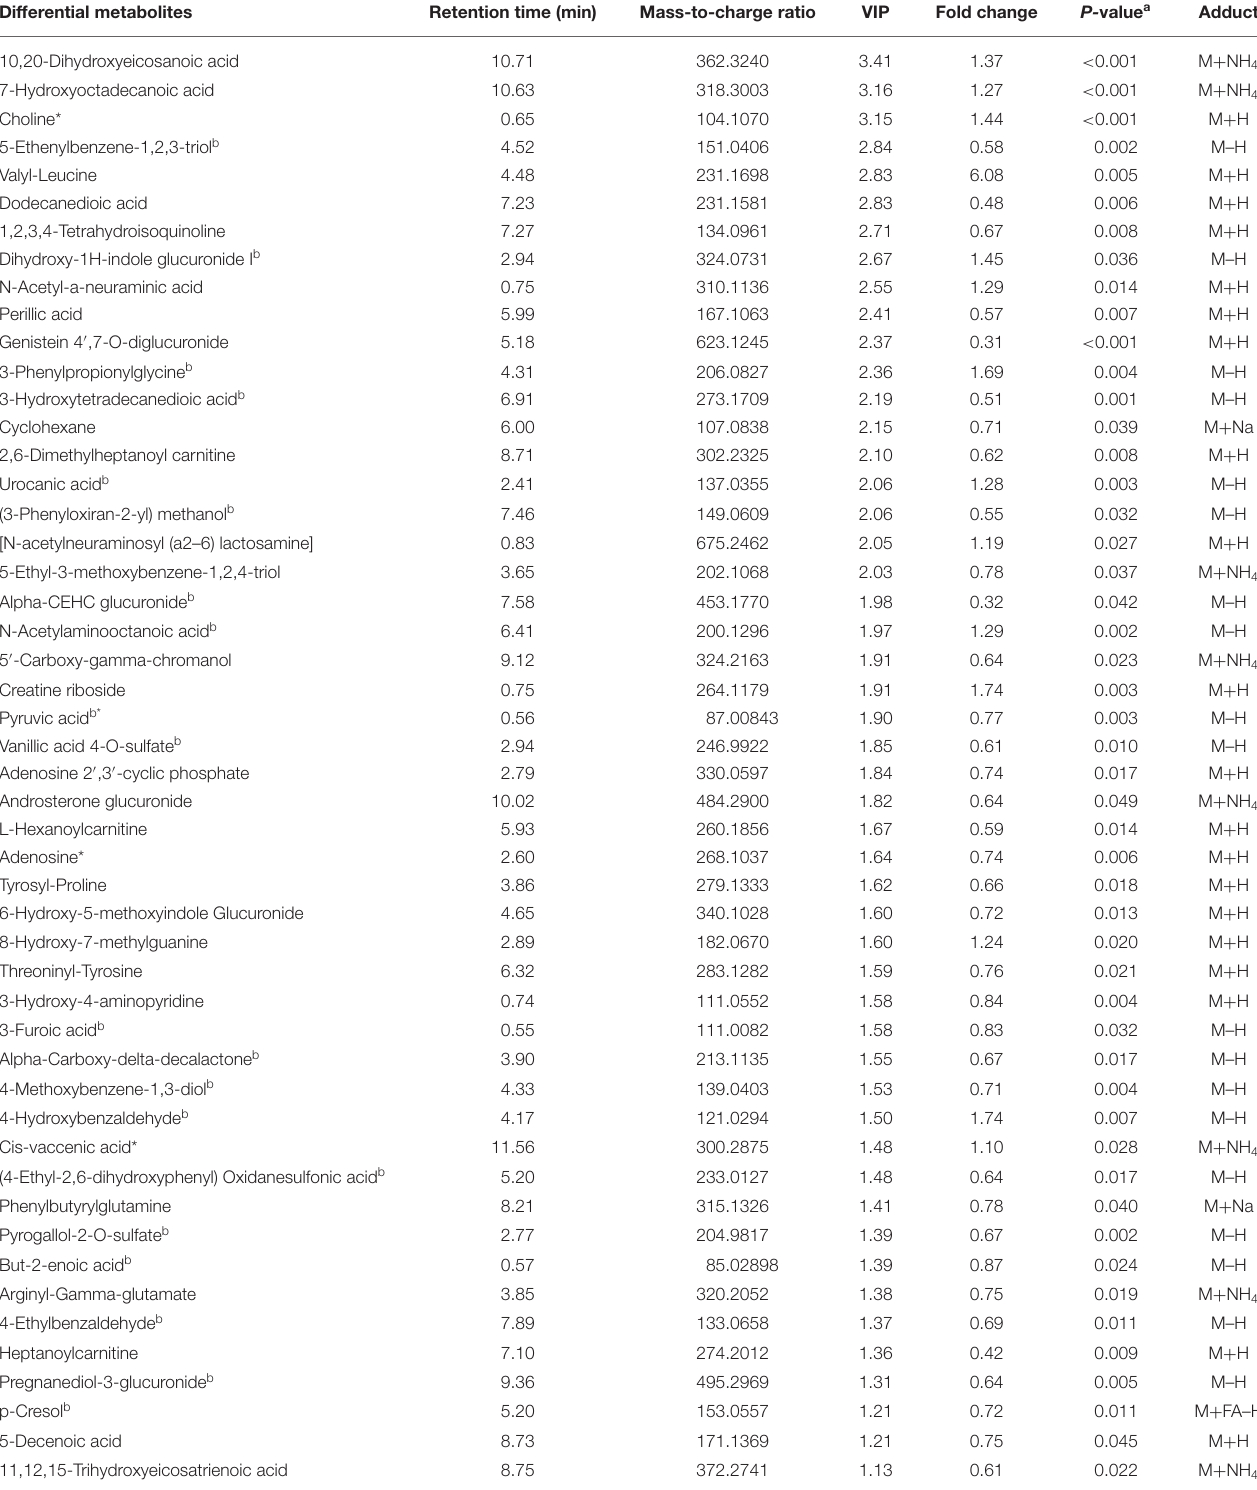
TABLE 3 | Statistical analysis of 50 differential metabolites in urine identified from the comparison of HSPN ( + ) vs. HSPN (–). Differential metabolites Retention time (min) Mass-to-charge ratio VIP Fold change P- value a Adduct